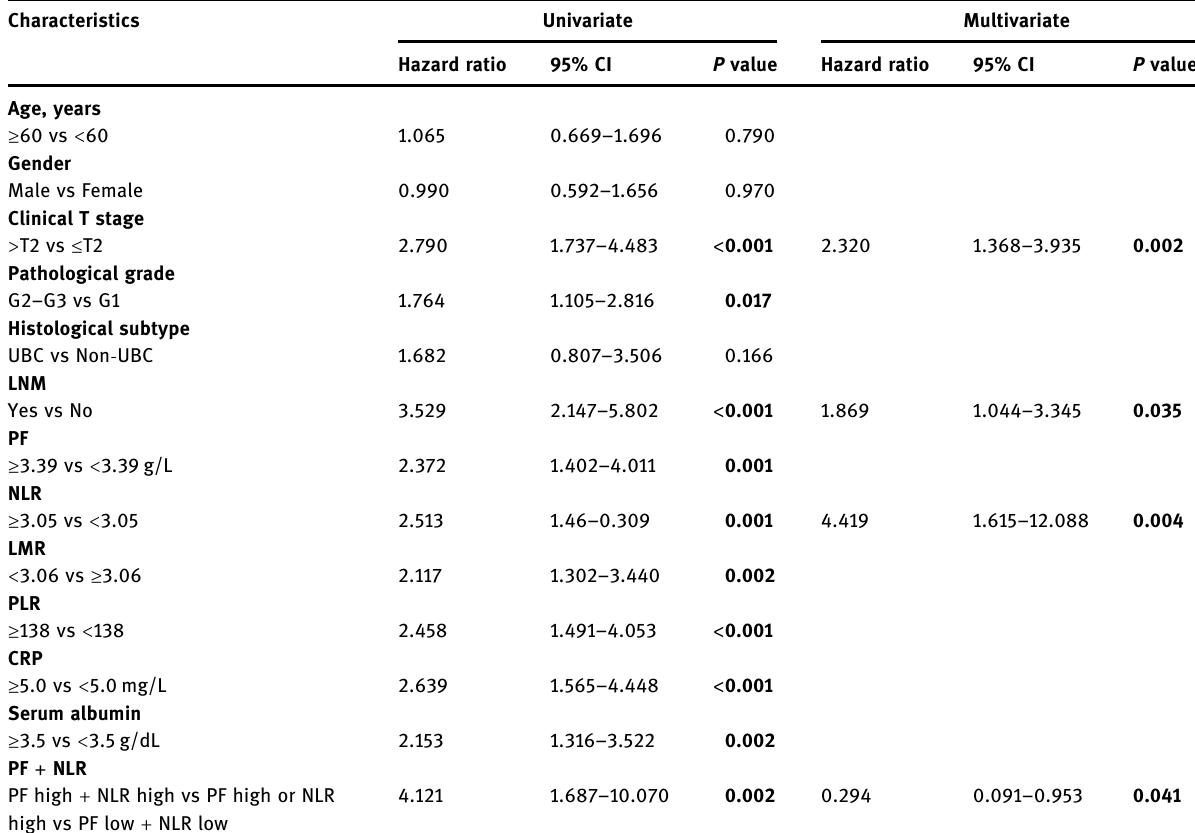
Table 1: Univariate and multivariate analyses of characteristics associated with OS in all 175 BC patients